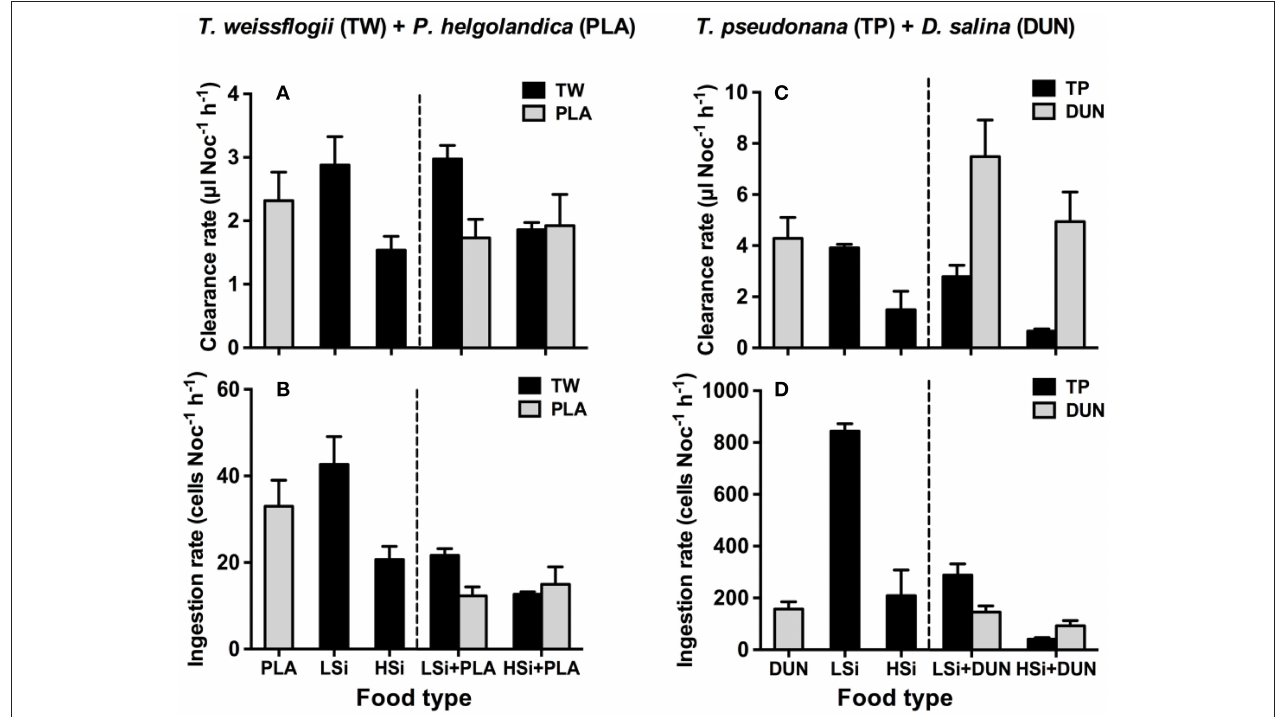
FIGURE 2 | Clearance and ingestion rates of Noctiluca scintillans on Thalassiosira weissflogii (A,B) and T. pseudonana (C,D) that contain different levels of biogenic silica in the single and mixed diet treatments (i.e., T. weissflogii + Platymonas helgolandica , T. pseudonana + Dunaliella salina ). LSi and HSi are low and high silica diatom prey, respectively. Error bars are 1 SD ( n = 3).